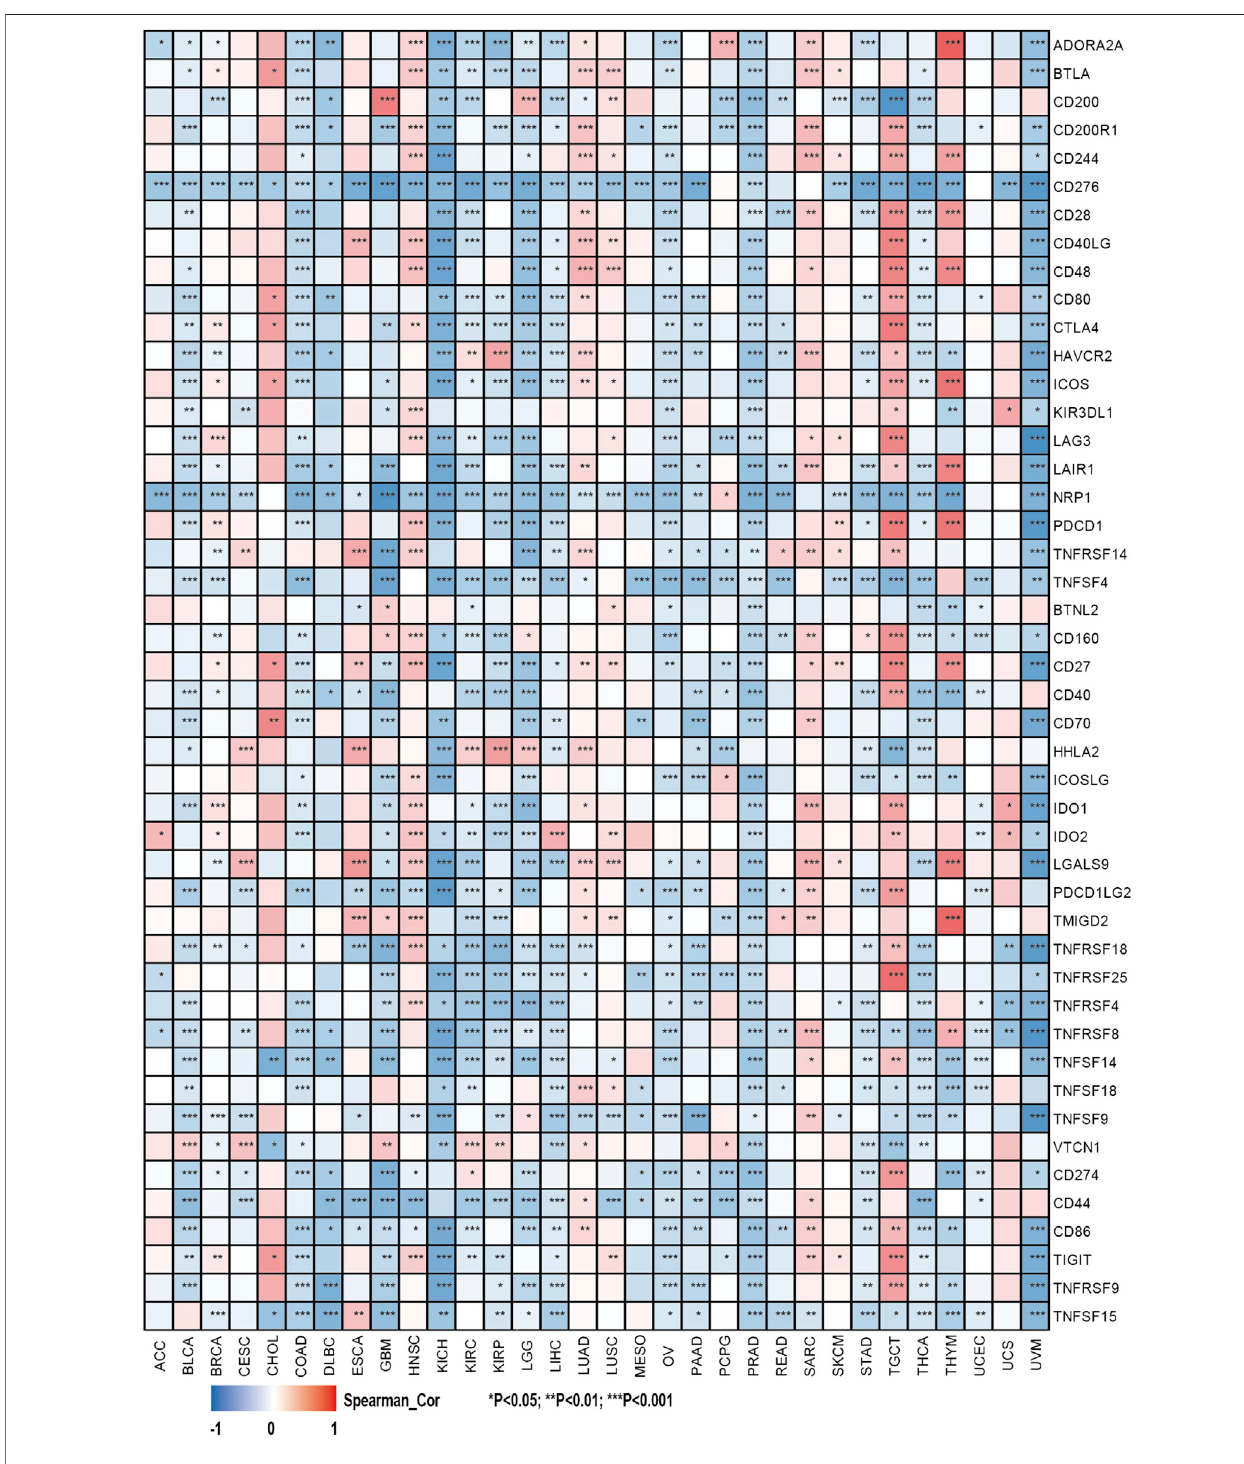
FIGURE 8 | Correlation analysis of SHC1 expression levels with the most common immune checkpoint gene levels in pan-cancer.